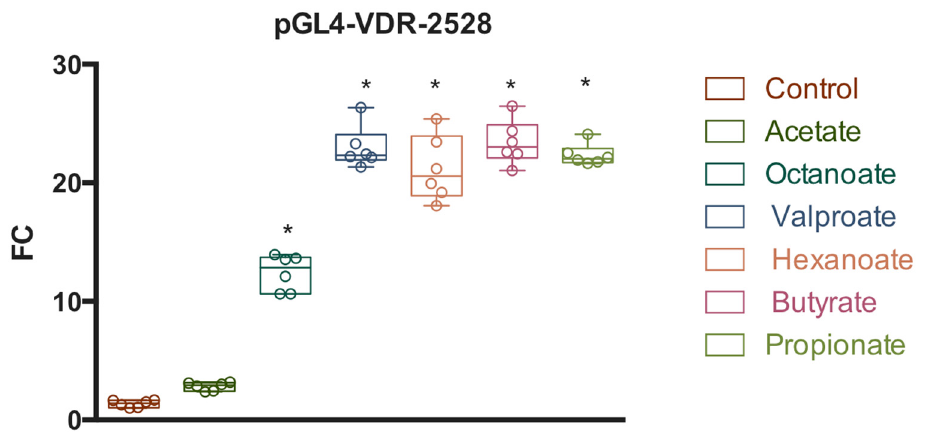
Figure 5. Response of a hVDR (human Vitamin D Receptor) gene promoter region of 2528 bp to SCFAs (short chain fatty acids). HepG2 cells were transfected with the pGL4-VDR-2528 ( − 591 to +1937) construct or pGL4 empty vector and treated with vehicle (control), acetate (5 mM), octanoate (5 mM), VPA (5 mM), hexanoate (5 mM), butyrate (5 mM), and propionate (5 mM). After 24 h, firefly luciferase activity was measured and normalized with Renilla luciferase activity (relative light units, RLUs). Results are expressed as mean ± SEM from six independent experiments. * p -value < 0.05, one-way ANOVA with Tukey’s multiple comparisons test.